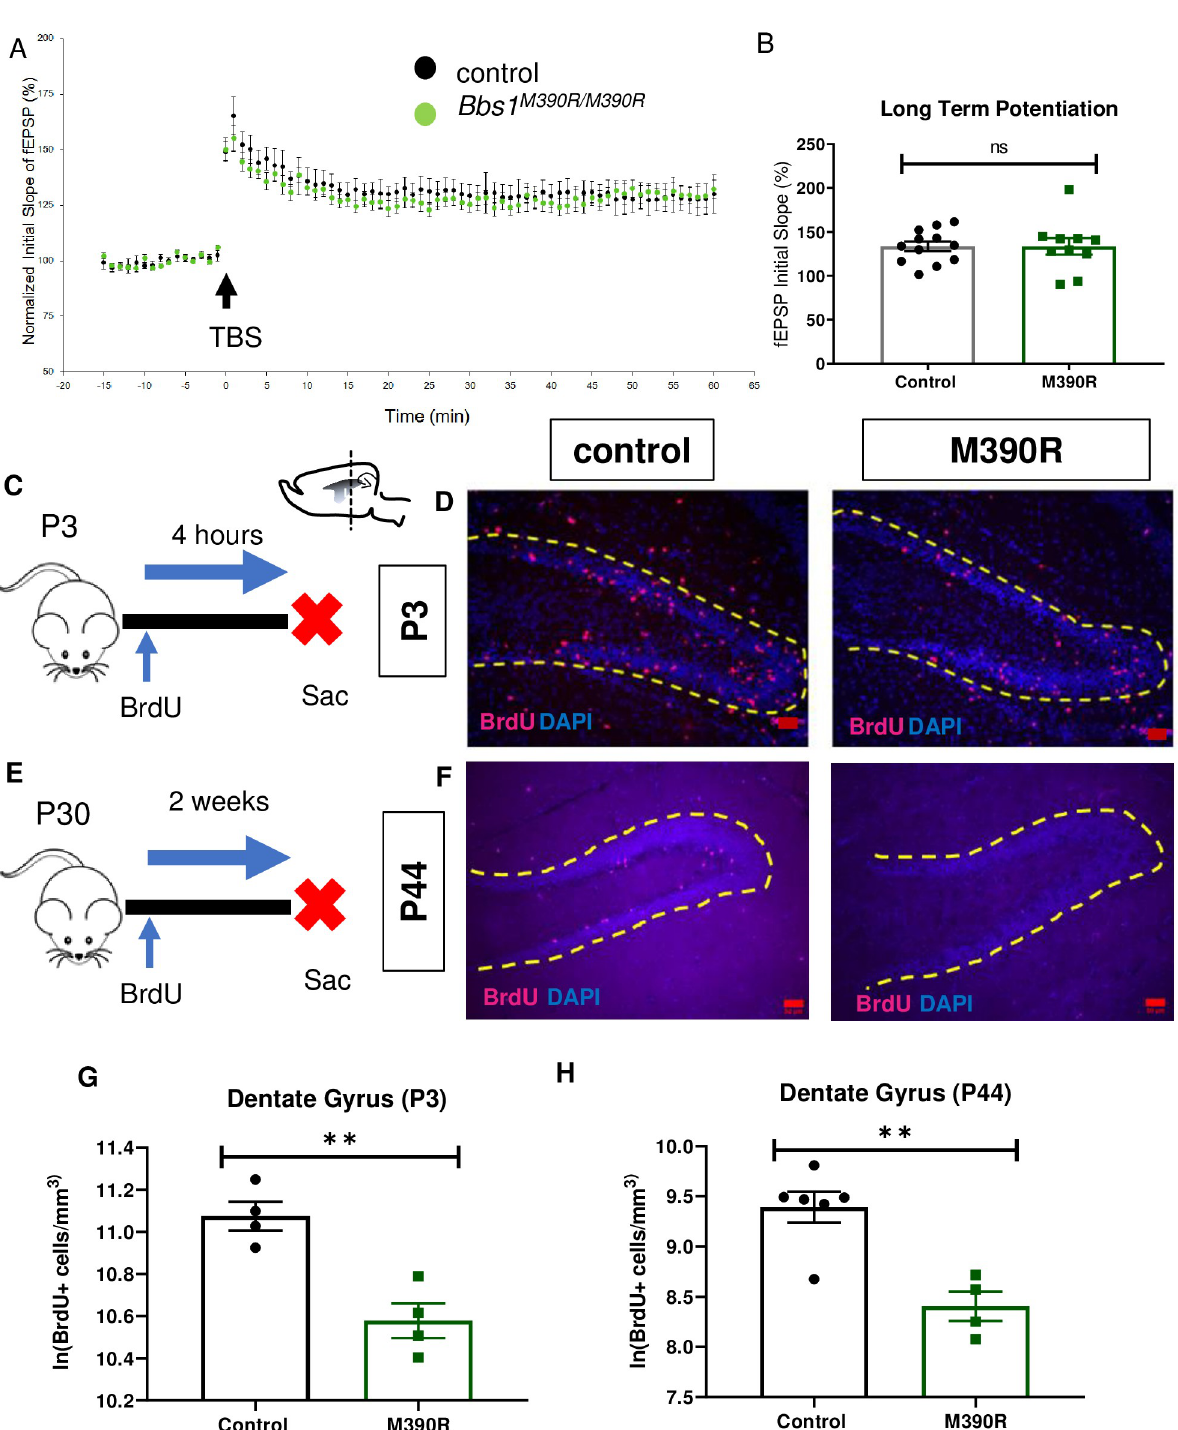
Fig 5. Bbs1 M390R/M390R mice have decreased hippocampal proliferation. A.) Normalized initial slope (%) recordings of field excitatory post synaptic potentials (fEPSP) in the hippocampal CA1 Schaffer-collateral pathway between 2 month male control mice (n = 17, 4 mice) and Bbs1 M390R/M390R mice (n = 16, 4 mice). LTP was induced by 12 theta burst stimulation (TBS). B.) The Long-Term Potentiation (average of last five minutes of normalized initial slope of fEPSP) in the hippocampal CA1 Schaffer-collateral pathway between 2 month male control mice (n = 17, 4 mice) and Bbs1 M390R/M390R mice (n = 16, 4 mice) did not differ significantly (Welch’s t-test, P = 0.8407). C.) Schematic diagram of the BrdU injections of postnatal day 3 (P3) mice. P3 mice were IP injected with 300mg/kg BrdU, and taken down four hours later. Sac = Sacrifice. D.) Inverted fluorescent microscope images of the P3 Dentate Gyrus. The sections were stained with Bromodeoxyruidine (BrdU) and counterstained with the nuclear marker,